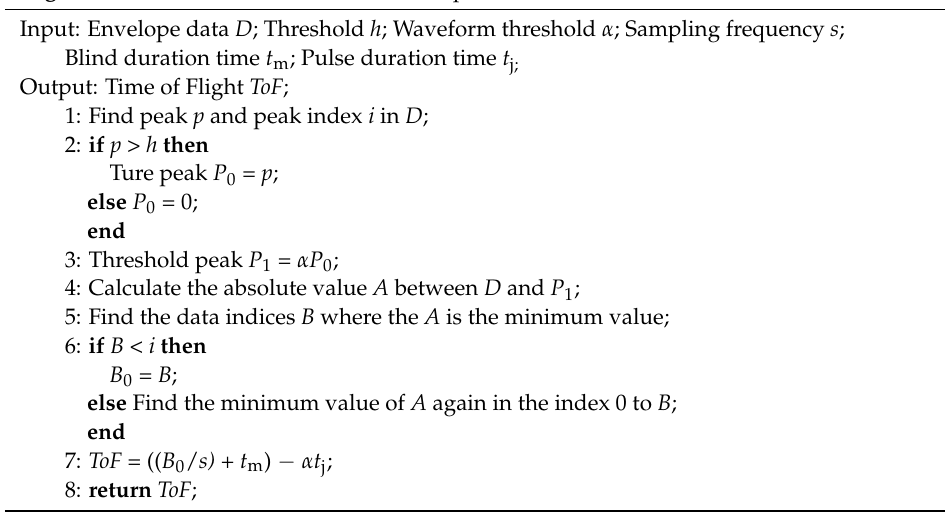
Algorithm 1: Calculate ToF from the envelope